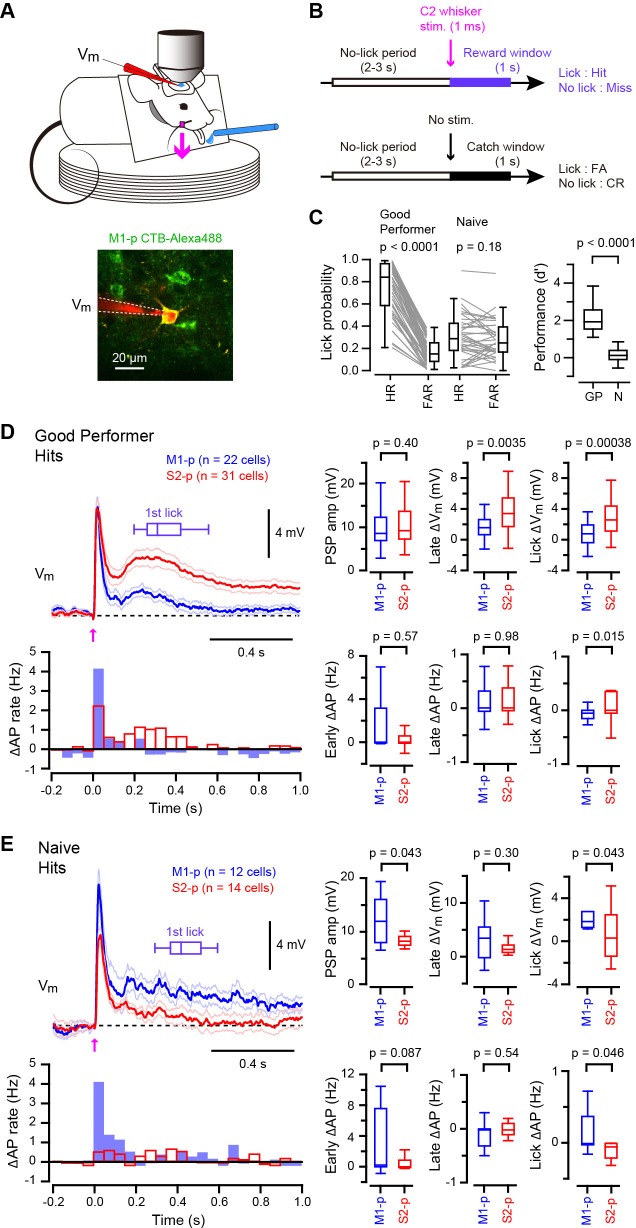
Target-specific Vm dynamics in S1 projection neurons during task performance.(A) Top, the experimental setup. Bottom, a representative two-photon image of a CTB-labeled M1-p neuron (green) with a recording pipette (red). (B) Detection task trial structure (FA: false alarm, CR: correct rejection). (C) Behavioral performance during whole-cell recordings (HR: hit rates, FAR: false alarm rates, GP: ‘Good performer’, N: ‘Naive’). (D, E) Left, grand average changes in Vm (thick line: mean, thin lines: ± sem) and action potential (AP) firing rate for hit trials recorded from S2-p neurons (red) and M1-p neurons (blue) in ‘Good performer’ (D) and ‘Naive’ (E) mice (Arrow: 1 ms stimulation of the C2 whisker). A box plot indicates reaction time (1st lick). Right, box plots for postsynaptic potential (PSP) amplitude, secondary late Vm depolarization quantified at 0.05–0.25 s, Vm depolarization during the lick period (at 0.25–1.0 s), and evoked AP rates at early (0–0.05 s), late (0.05–0.25 s) and lick (0.25–1.0 s) periods.DOI:
http://dx.doi.org/10.7554/eLife.15798.00310.7554/eLife.15798.004Figure 1—source data 1.Data values and statistics underlying Figure 1.DOI:
http://dx.doi.org/10.7554/eLife.15798.00410.7554/eLife.15798.005Figure 1—source data 2.Data values and statistics underlying Figure 1—figure supplement 3.DOI:
http://dx.doi.org/10.7554/eLife.15798.00510.7554/eLife.15798.006Figure 1—source data 3.Data values and statistics underlying Figure 1—figure supplement 4.